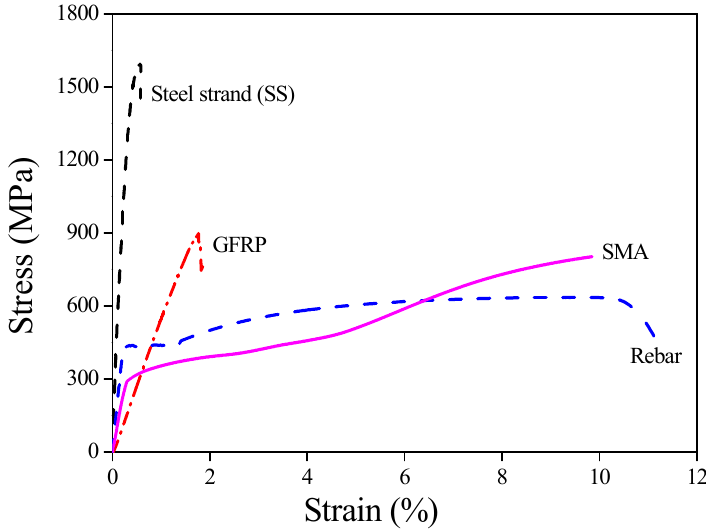
Figure 5. Stress–strain relationship of four different materials under uniaxial tensile loading.